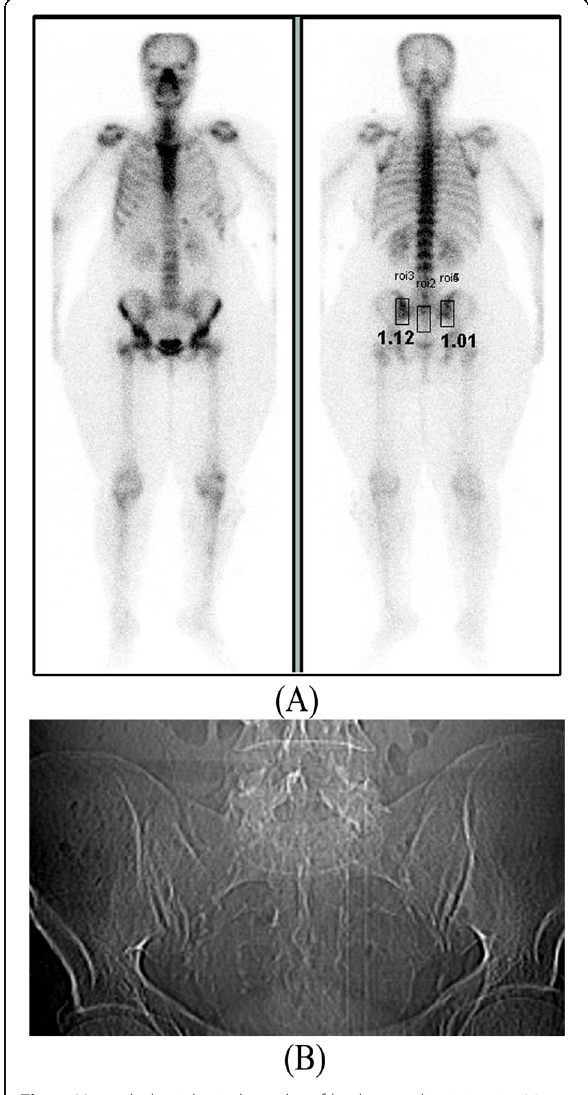
Fig. 1 Normal physiological uptake of both sacroiliac joints in 38 years old female. a Tc-99 m MDP whole-body bone scintigraphy (anterior and posterior views) shows right SII = 01.01 and left SII = 1.12. b X-ray radiography of sacroiliac joints (AP view) shows normal both sacroiliac joints